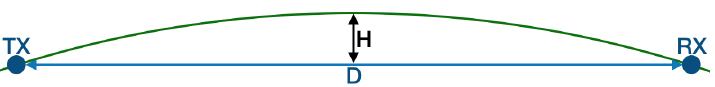
Figure 4. Example of the height of the Earth bulge in transmission